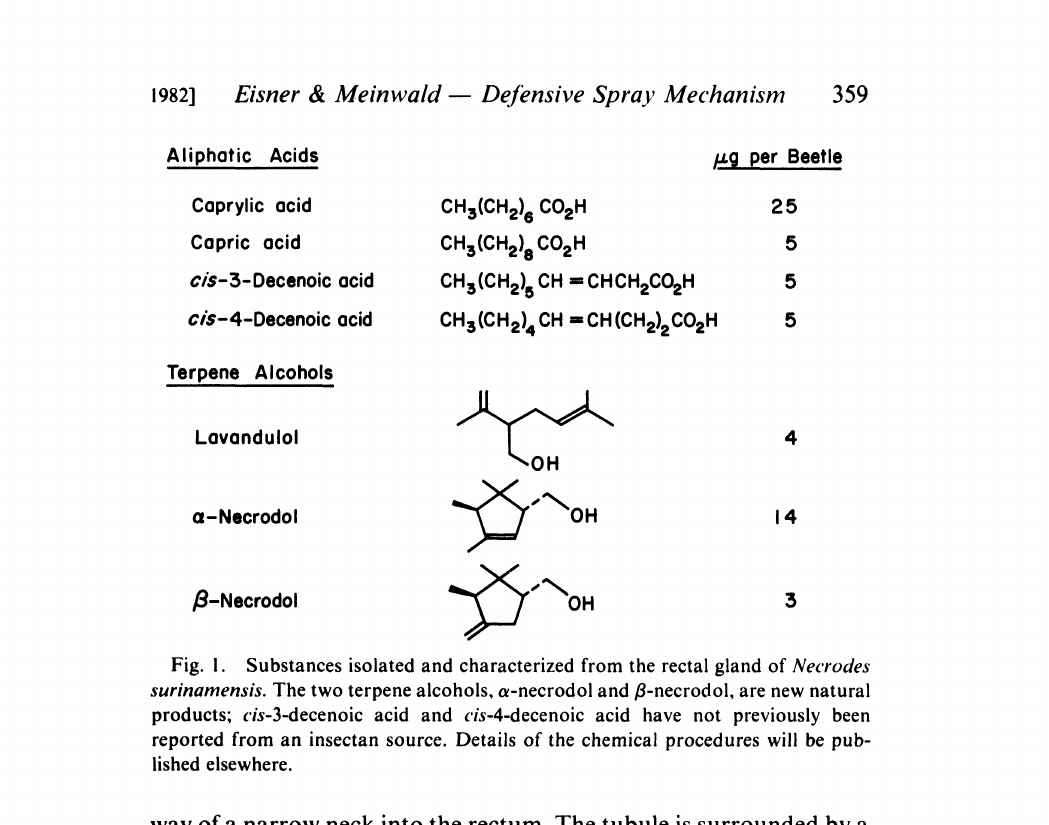
Fig. 1. Substances isolated and characterized from the rectal gland of Necrodes surinamensis. The two tcrpcnc alcohols, -nccrodol and/-nccrodol, arc new natural products; cis-3-dcccnoic acid and cis-4-dcccnoic acid have not previously bccn reported from an inscctan source. Details of the chemical procedures will be pub- lishcd